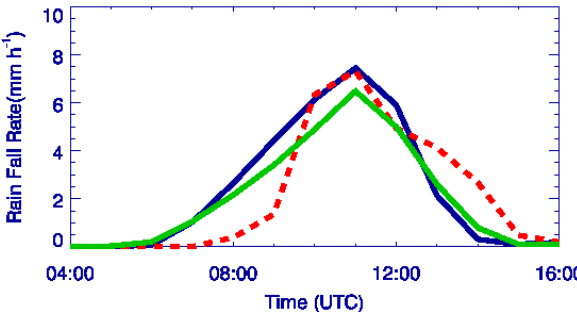
Figure 8. Fig. 8. Temporal evolution of the domain-averaged rainfall rate. The red dashed line represents the gauge measurement, the blue solid line corresponds to the P-case, and the green solid line corre- sponds to the